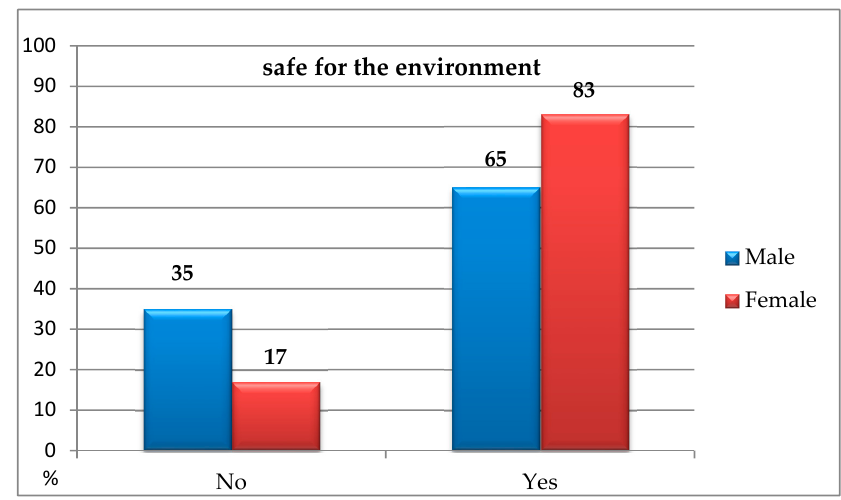
Figure 1. Preference of ecological goods due to their environmentally friendly aspect among people of different gender.